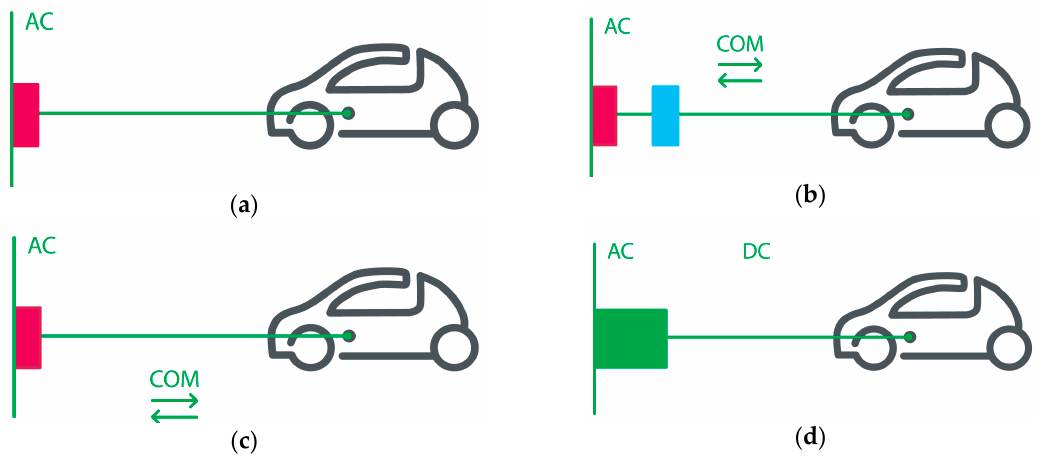
Figure 1. Different charging methods defined in IEC 61851-1: ( a ) Mode 1; ( b ) Mode 2; ( c ) Mode 3; ( d ) Mode 4.